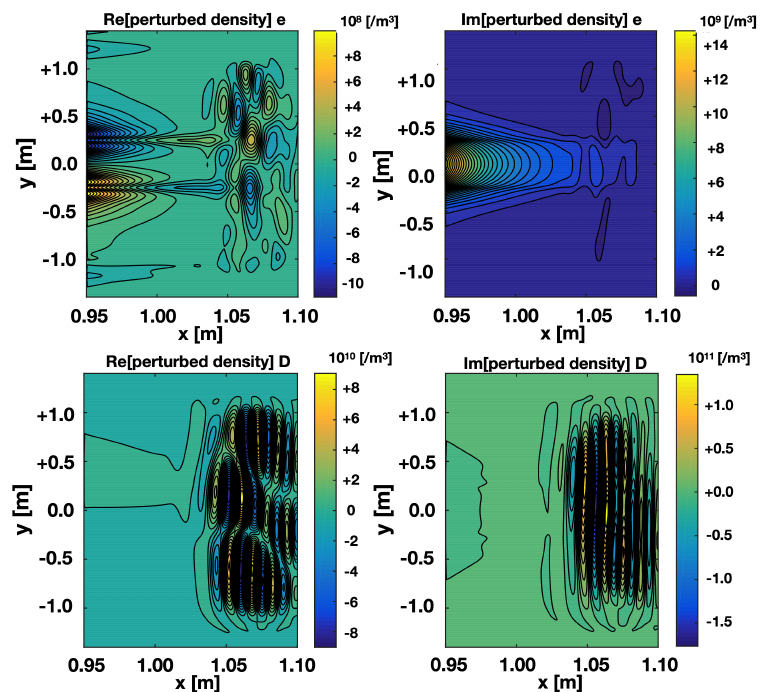
Figure 7. Perturbed density of the electrons, e ( top ), and deuterons, D ( bottom ), corresponding to the electric field shown in the bottom of Figure